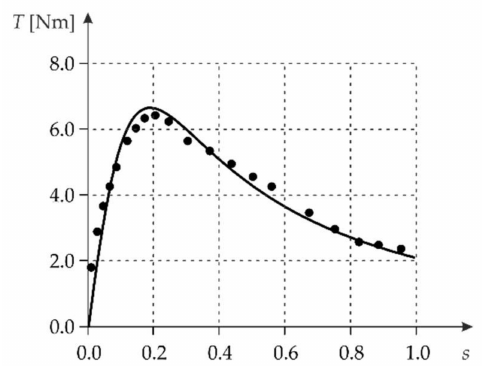
Figure 7. Results from our MC-based model of the